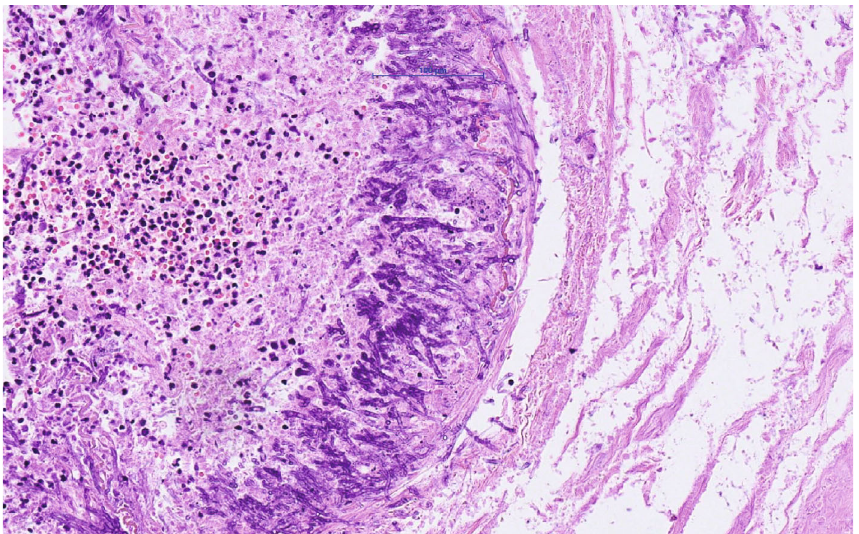
Figure 2: Higher magni fi cation (20x) of marked area in the